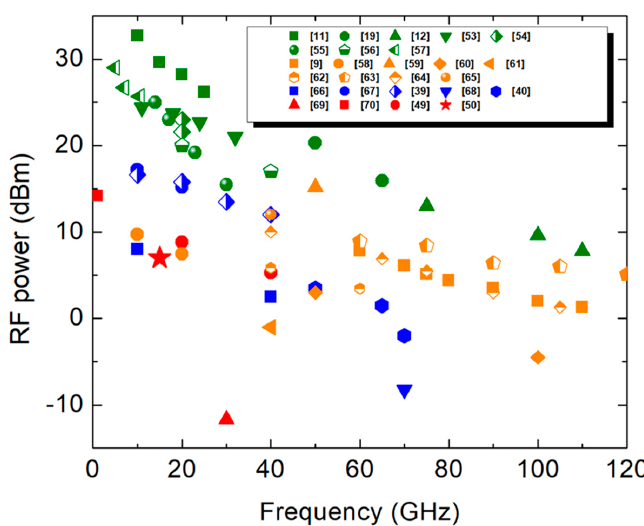
12 Figure 16. ( a ) Phase-modulated link gain measurement setup. ( b ) Measured and calculated RF gain spectra of the phase-modulated link at 2 and 7 mA photocurrent for each PD. 5. Conclusion Figure 17 summarizes the RF output power versus frequency of PDs for high-power analog applications that have been reported in the literature. The green data points represent normal- incidence PDs onnative InP substrate. The RF output power reaches over 30 dBm at 10 GHz to 7 dBm at 100 GHz. Uniform light illumination, good thermal dissipation due to the flip-chip bonding on materials of high thermal conductivity, and advanced heterostructure designs yielded such high RF output power levels. The yellow data points represent the RF output power from waveguide PDs on native InP substrate. The output powers are lower than those of surface normal incident PDs due to the non-uniform light coupling from the waveguide into the absorber, which can cause localized space charge effects. The state-of-the-art performance of waveguide PDs on Si based on III-V